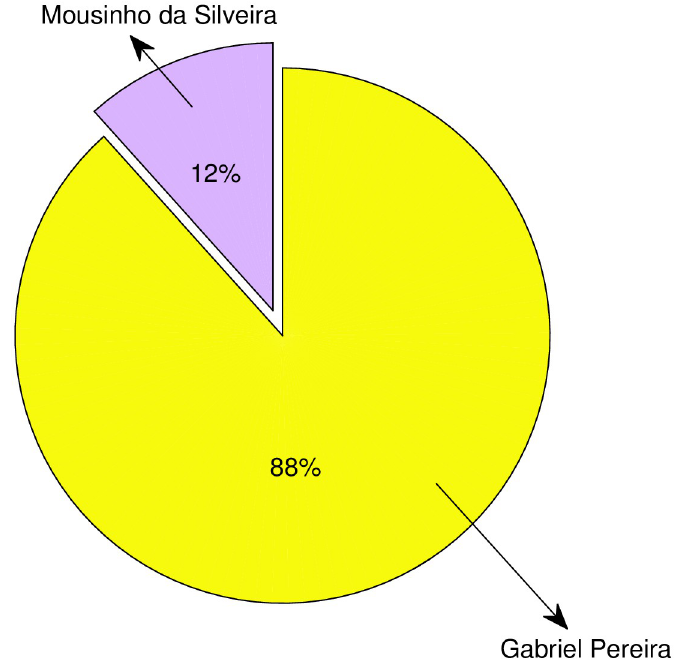
Fig 6. Proportions of two Portuguese